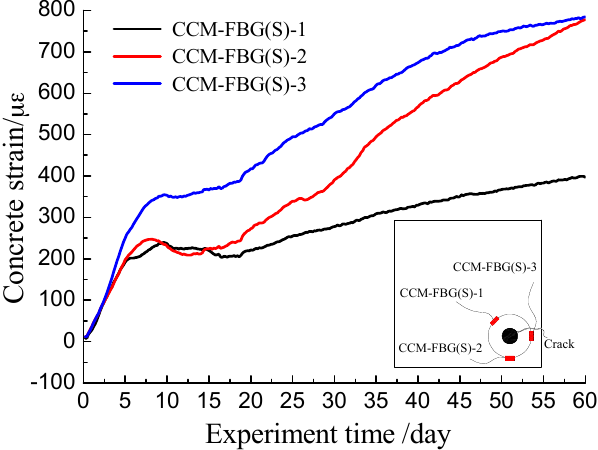
Figure 9. Concrete strain over the course of the accelerated corrosion experiment. Figure 10. Concrete strain over the course of the accelerated corrosion